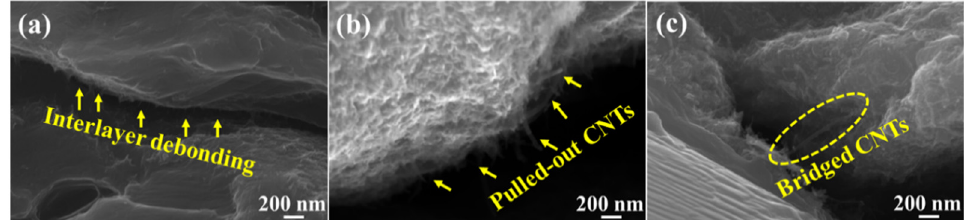
Figure 7. SEM-SE fracture micrographs of 0.5 wt.% CNTs/Mg composites. ( a ) interlayer debonding between adjacent Mg foils after tensile deformation; ( b , c ) demonstrate the pulled-out and bridged CNTs at the fractured surfaces, respectively.